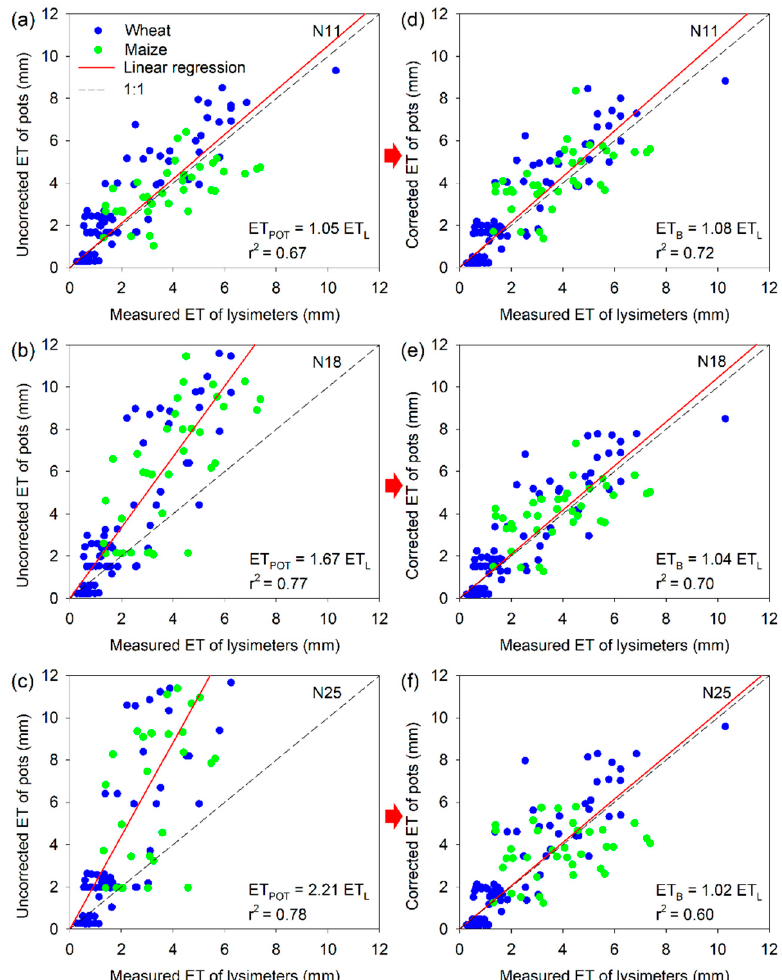
Figure 11. Comparisons between the uncorrected ET (ET POT ) or corrected ET (ET B ) for the pots with different soil water treatments (( a ) 11%, ( b ) 18%, and ( c ) 25% for the uncorrected and ( d ) 11%, ( e ) 18%, and ( f ) 25% for the corrected) and measured ET values derived from the lysimeters (ET L ). A linear regression was applied to the data for the wheat and maize seasons. r 2 is the determination coefficient of the linear regression.